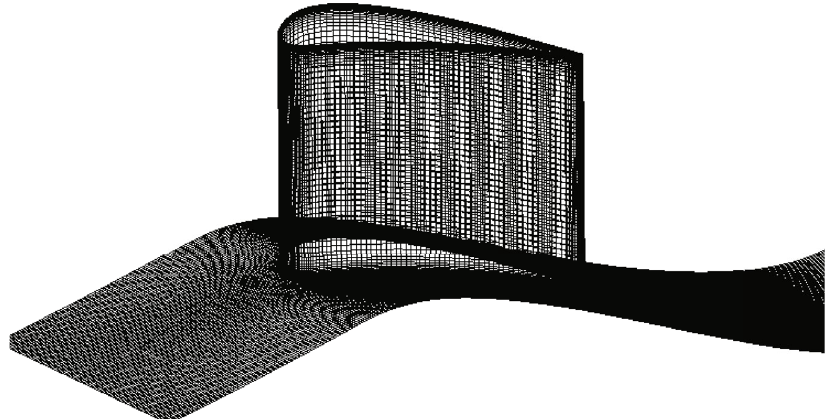
Figure 5: Detail of mesh.